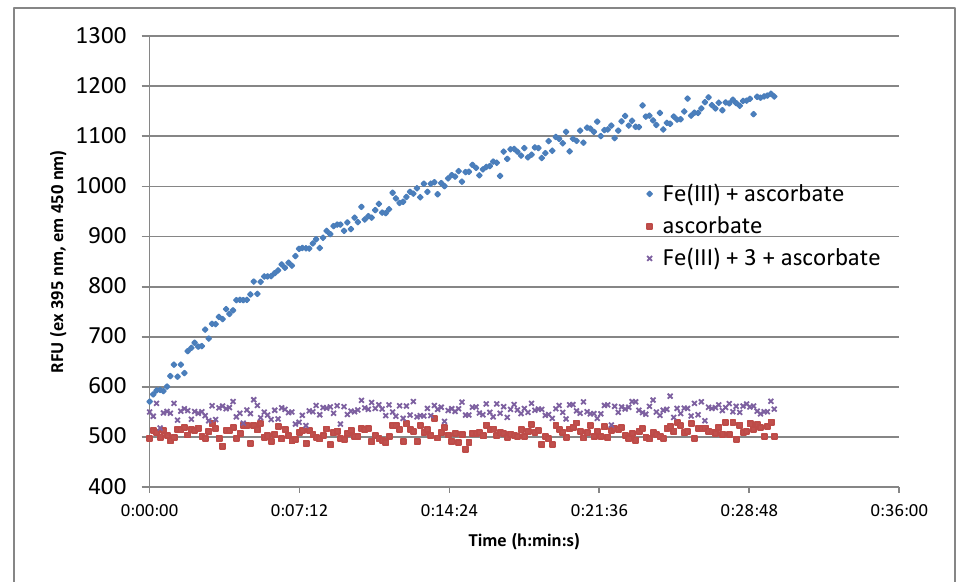
Figure 5. Fluorescence intensity of 7-hydroxy-CCA after incubation of CCA [100 µM] and Fe(III) [10 µM] with ascorbate [300 µM] ( ♦ ). Compound 3 (×) [30 µM] was added 30 min prior to ascorbate. Ascorbate ( ■ ) is a negative control with CCA, buffer, 3 and ascorbate without Fe(III). All solutions except FeCl 3 (dissolved in Milli-Q water only) were prepared in KH 2 PO 4 [20 µM], NaCl [100 µM] buffer containing desferryl [1 µM], pH = 7.4.